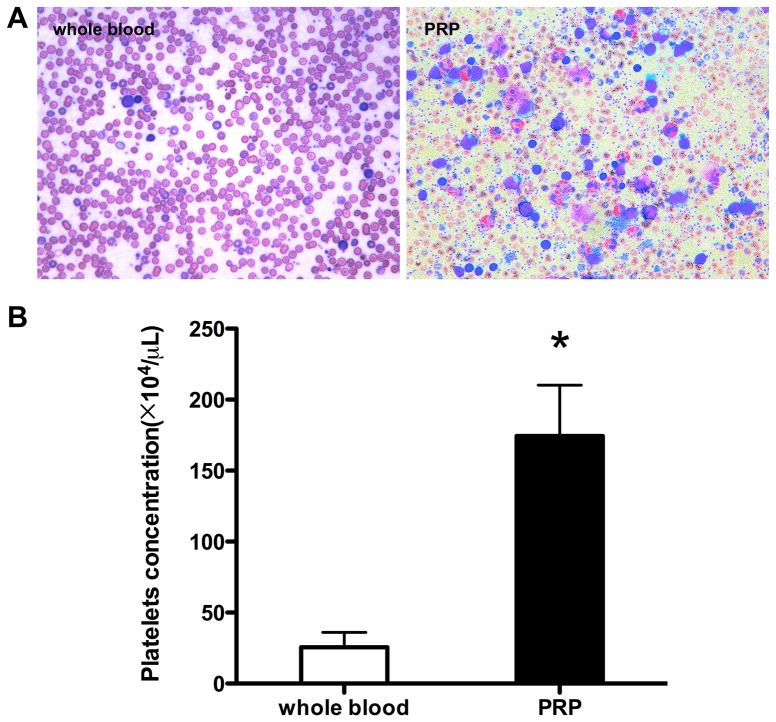
The concentrates of platelets in PRP and whole blood.(A): The smear of PRP and whole blood. Platelets and white blood cells were highly concentrated in PRP. (B): The platelets counting of PRP and whole blood. * denotes statistically different significance compared with whole blood (p<0.01).